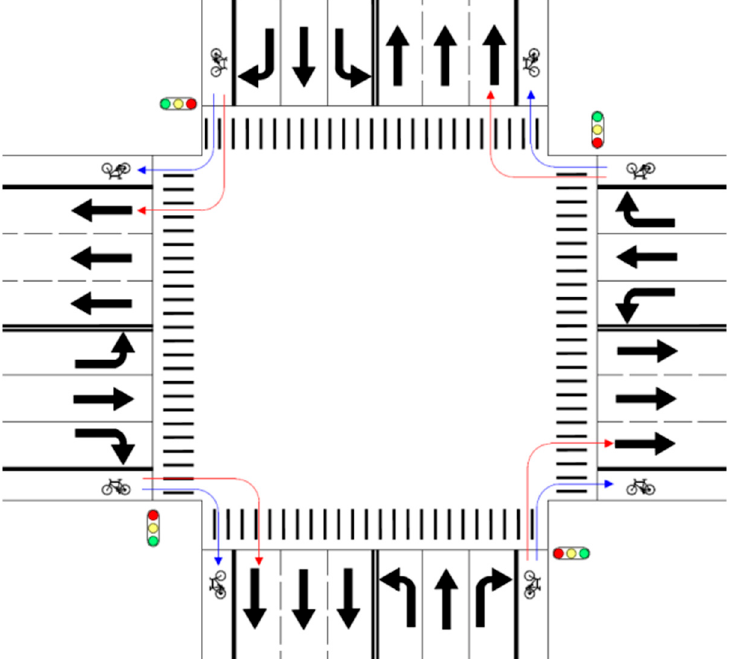
Figure 2. Trajectories of right-turning non-motorized vehicles with blue lines for choice of lane for non-motorized vehicles and red lines for choice of lane for motorized vehicles.